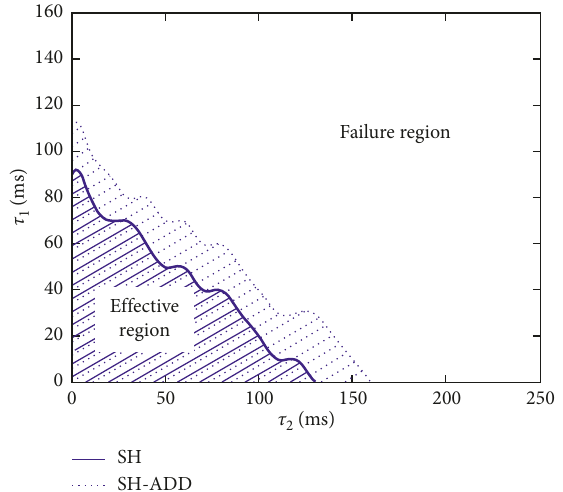
Figure 27: Time delay boundary curves of SH and SH-ADD controls when the velocity is